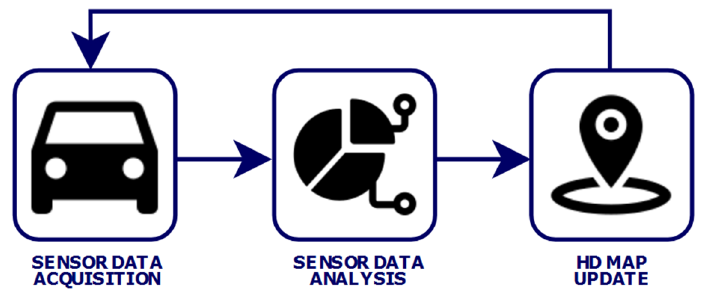
Figure 8. The flow of information from the vehicle to the complete updating of HD maps based on [28].